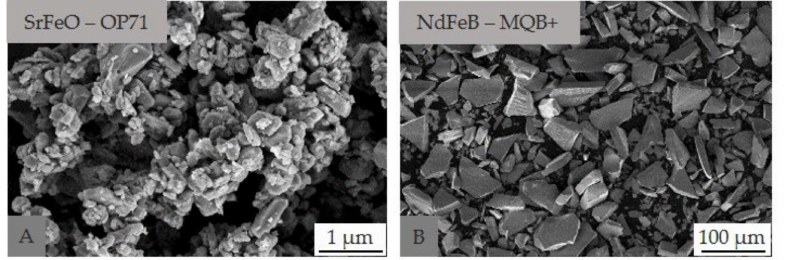
Figure 2. Particle geometry of anisotropic SrFeO ( A ) and isotropic NdFeB ( B ) using a